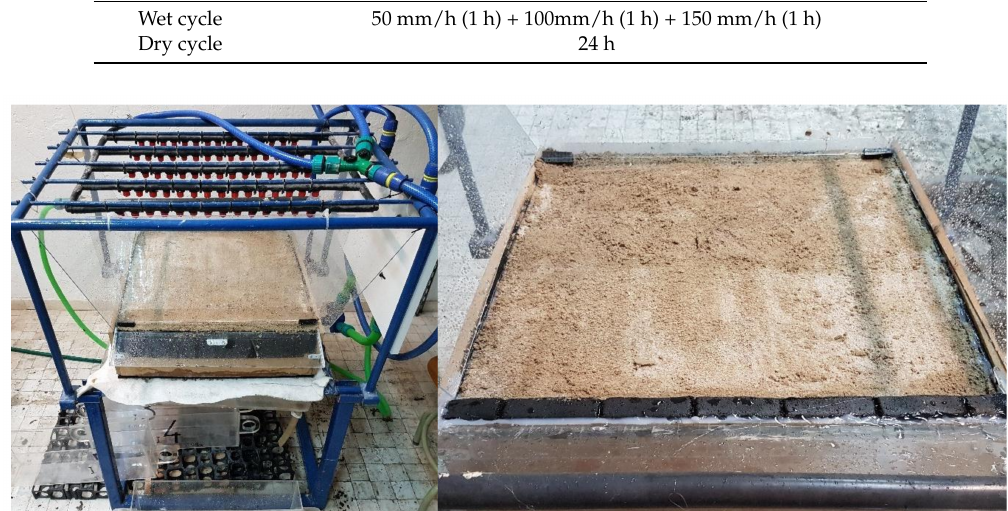
Figure 2. Experimental set-up of rainfall simulations used after applying clogging sediments and prior to permeability